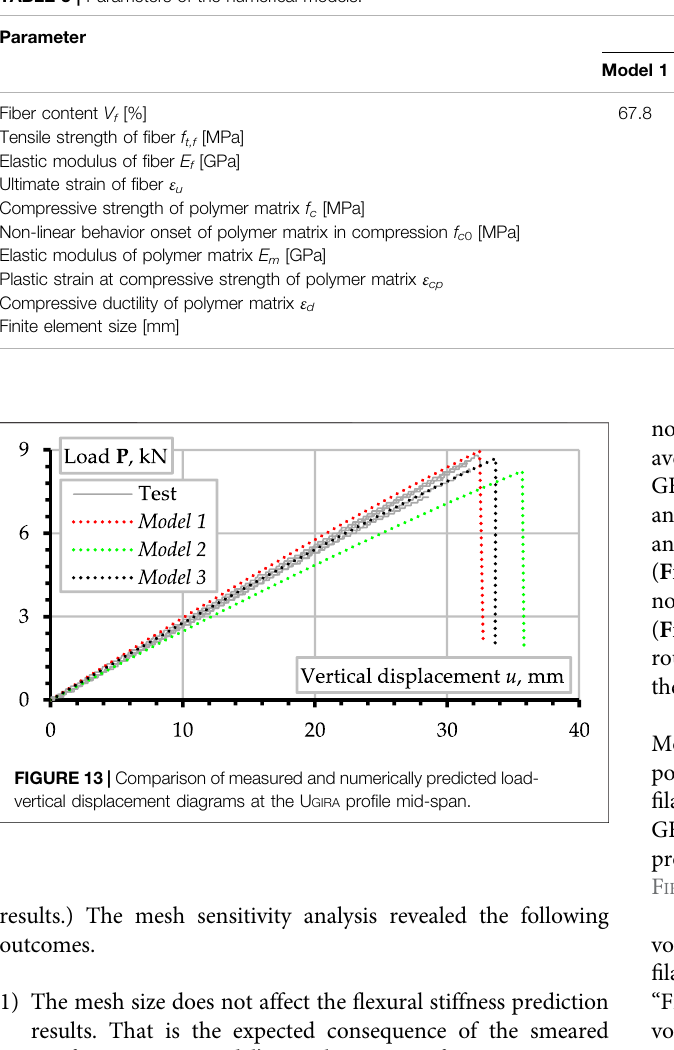
Frontiers in Materials |